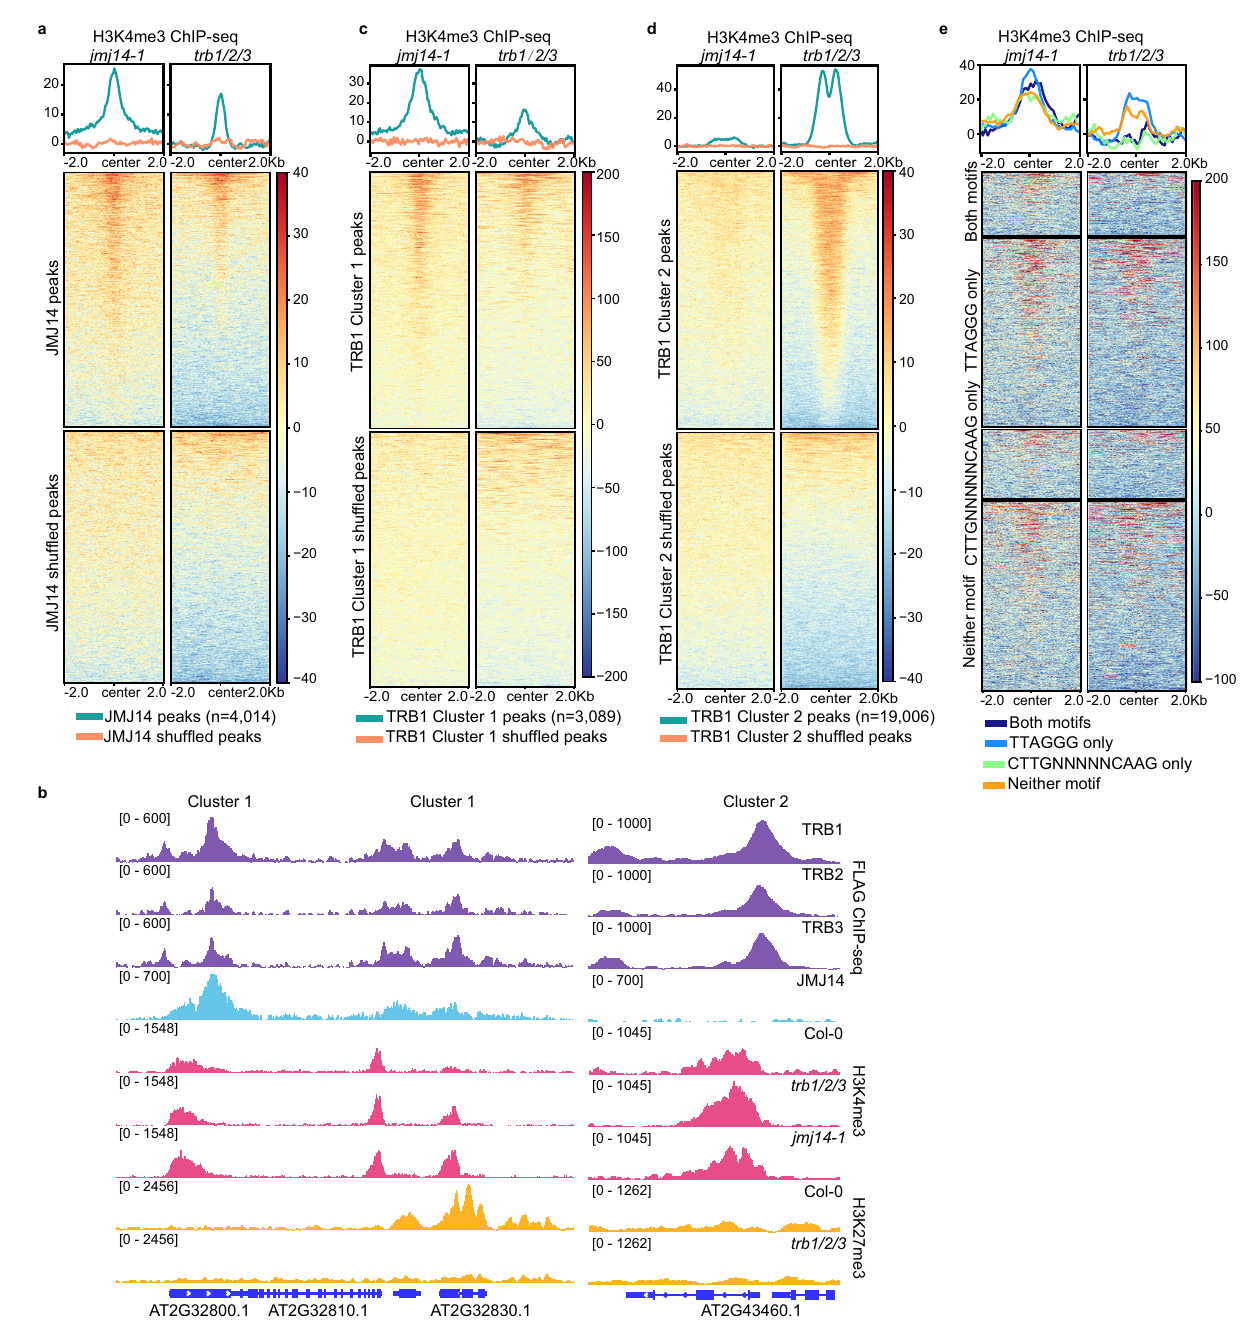
Fig. 3 | H3K4me3 ChIP-seq signals are increased in both jmj14-1 and trb1/2/3 mutants. a Metaplots and heatmaps showing the normalized H3K4me3 ChIP-seq levelsof jmj14-1 and trb1/2/3 mutantsversusCol-0wildtypeplants,overFLAG-JMJ14 peaks and shuf fl ed peaks ( n =4014). b Screenshots displaying the FLAG ChIP-seq signals of FLAG-TRB1, FLAG-TRB2, FLAG-TRB3, and FLAG-JMJ14, histone H3K4me3 ChIP-seq signals of Col-0, trb1/2/3 and jmj14-1 mutants, and H3K27me3 ChIP-seq signals of Col-0 and trb1/2/3 mutant over four representative loci. c – e Metaplots